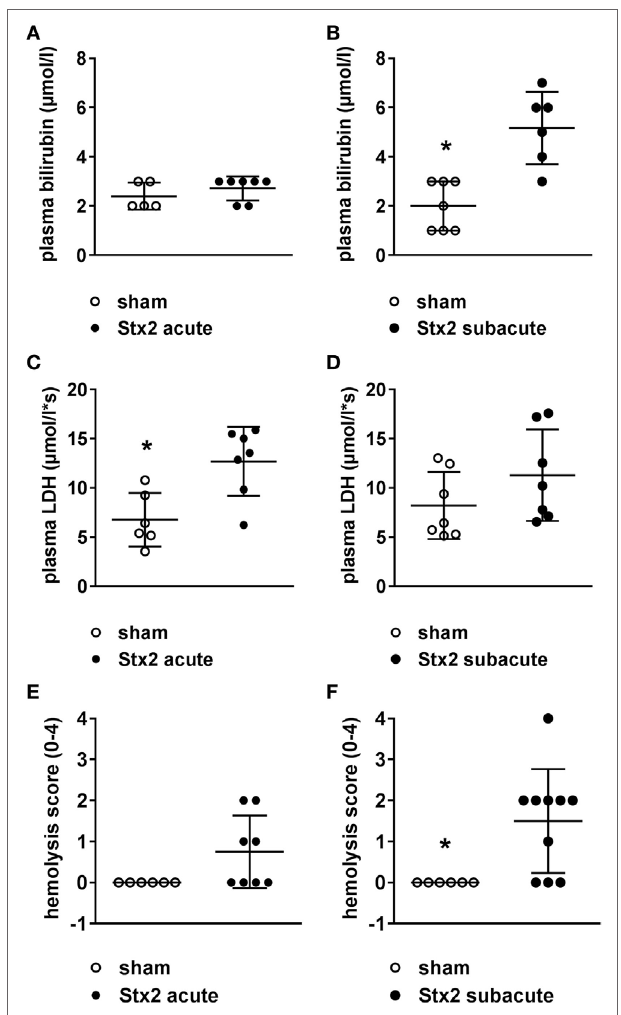
FigUre 4 | Indicators of hemolysis in C57BL/6J mice subjected to different Stx2 regimens. Plasma bilirubin levels were measured for the (a) acute model (sham n = 5, Stx2 n = 7) and (B) subacute model (sham n = 7, Stx2 n = 6). Plasma lactate dehydrogenase (LDH) levels were measured for the (c) acute model (sham n = 6, Stx2 n = 7) and (D) subacute model (sham n = 7, Stx2 n = 7). ( a–D) Data are expressed as mean ± SD for n observations. * p < 0.05 sham vs. Stx2 ( t -test). Hemolysis was photometrically quantified in plasma samples of the (e) acute model (sham n = 6, Stx2 n = 8) and (F) subacute model (sham n = 6, Stx2 n = 10). (e,F) Data are expressed as mean ± SD for n observations. * p < 0.05 for sham vs. Stx2 (Mann–Whitney U